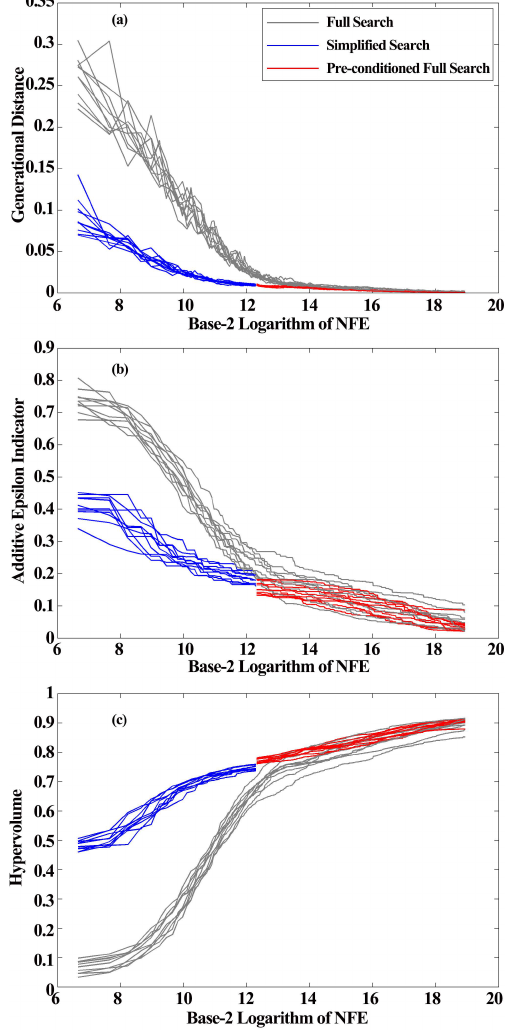
Figure 10. Performance metrics for the inter-basin multi-reservoir water supply operation problem – (a) generation distance, (b) addi- tive epsilon indicator, and (c)